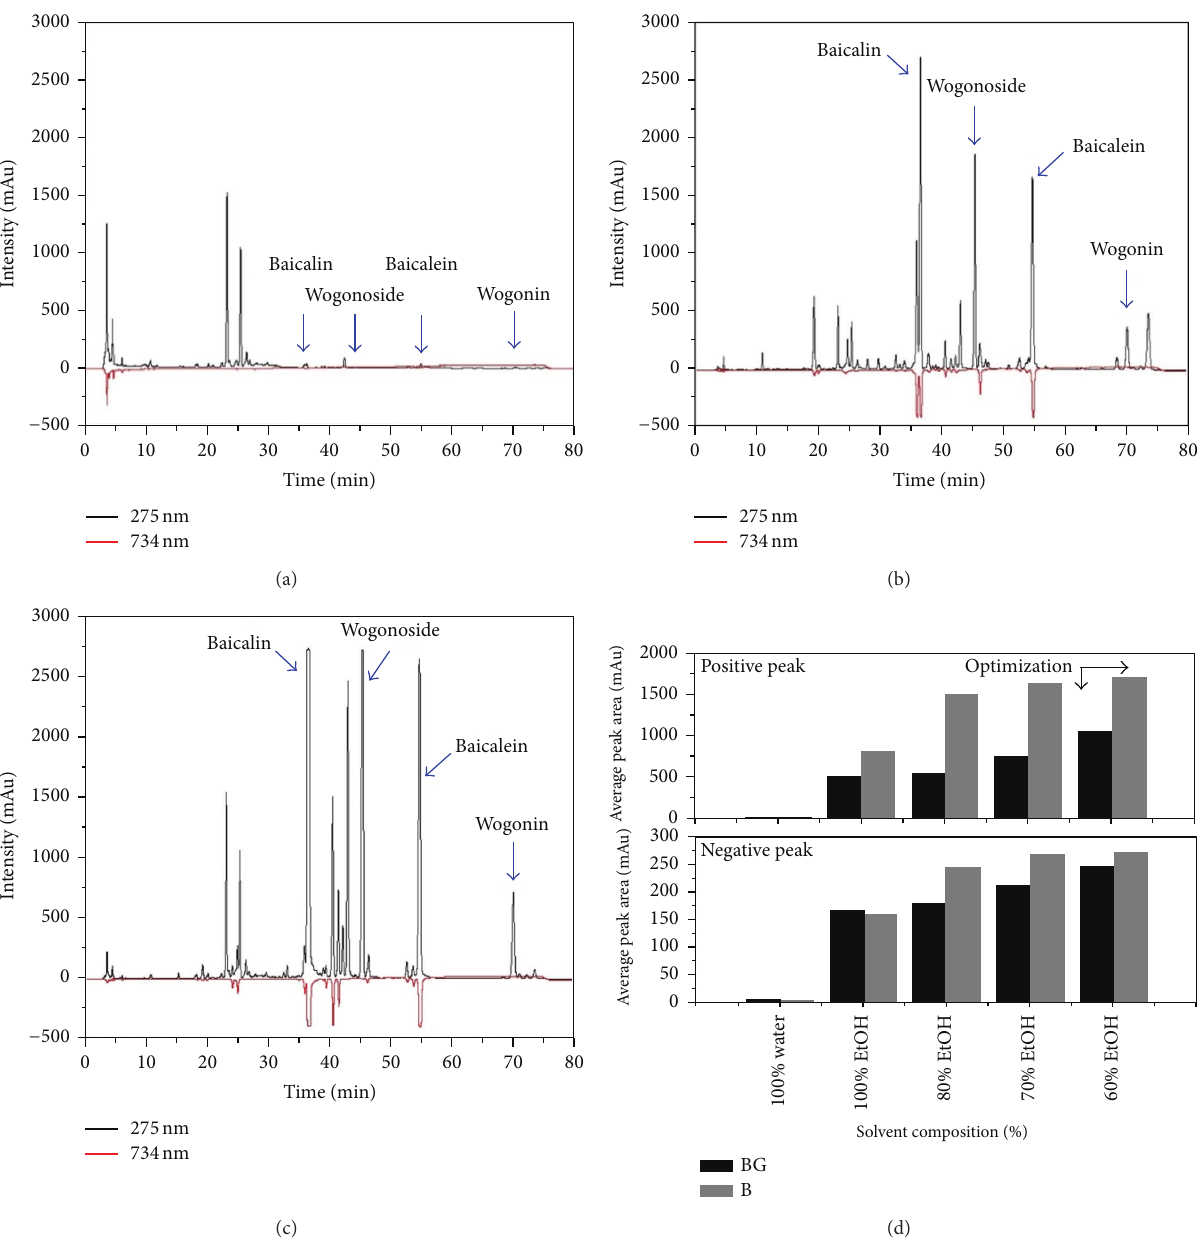
Figure 5: Chromatogram and column symbol of online screening HPLC profile of S. baicalensis extracts. Upper profile: UV signal at 275 nm, lower profile: ABTS reduction signal at 734 nm, (a) 100% water, (b) 100% EtOH, (c) 60% EtOH, and (d) negative and positive average peak